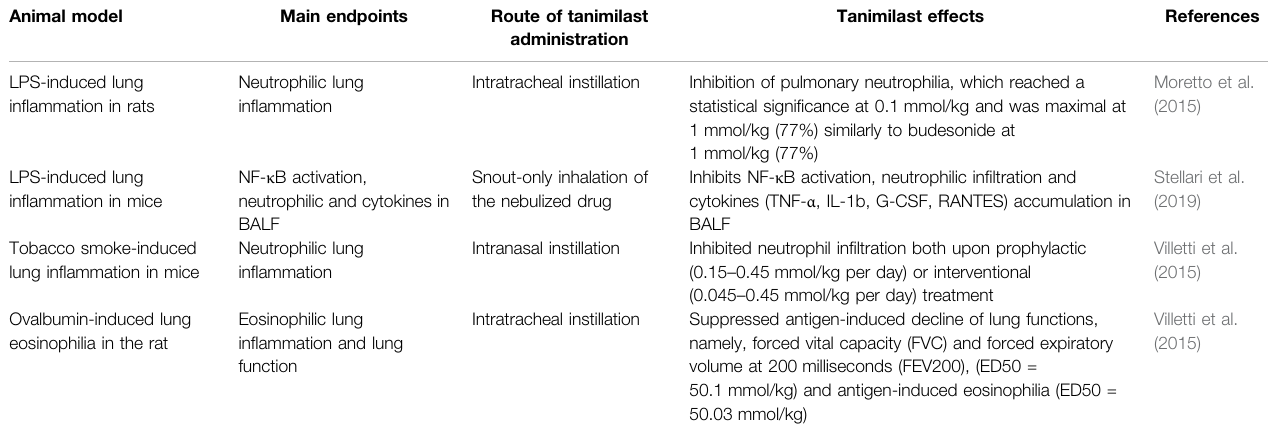
TABLE 2 | Anti-in fl ammatory effects of tanimilast in various experimental rodent models of pulmonary in fl ammation. Animal